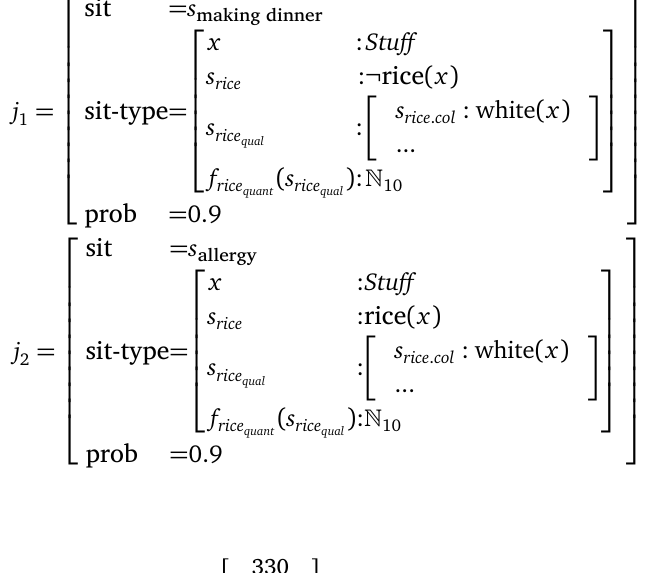
Possible (partial) judgement set for around 10 grains of